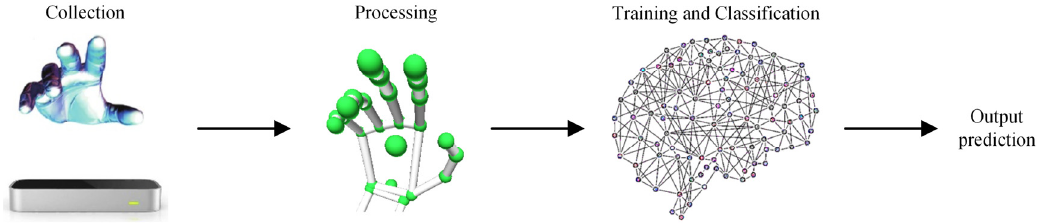
Figure 1. The architecture of the recognition system.